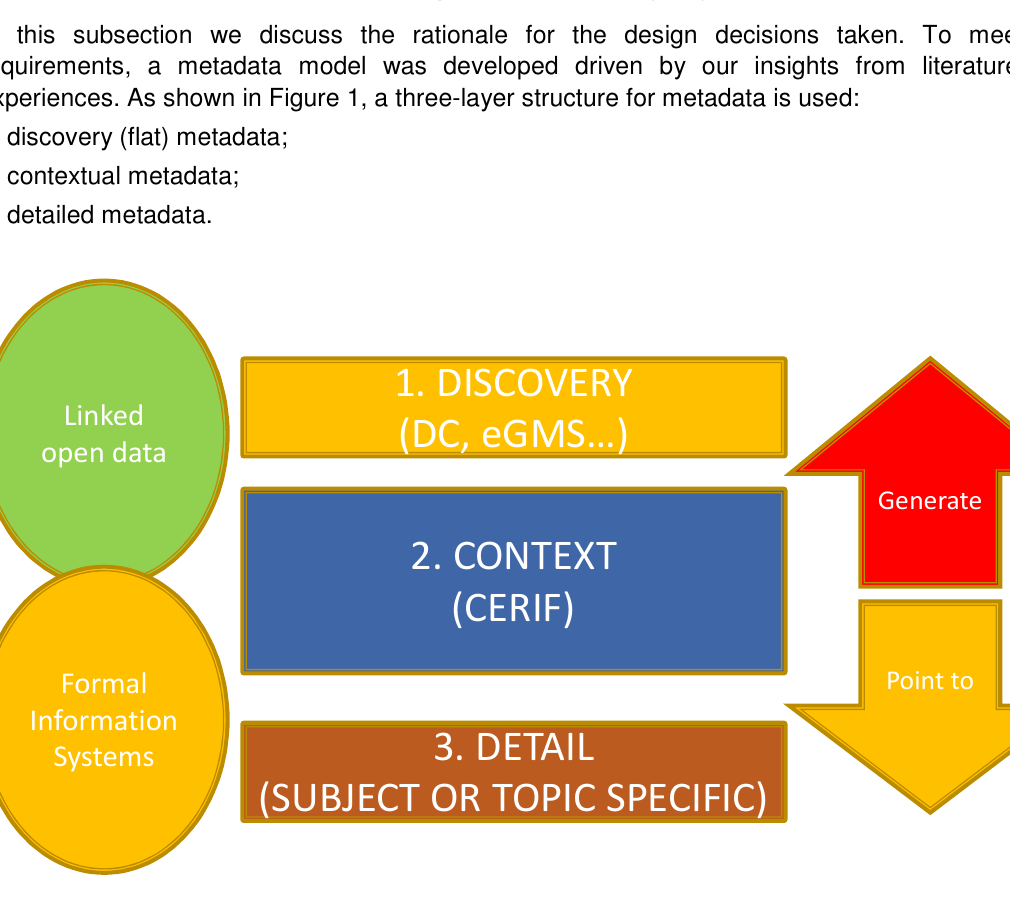
Figure 1: The three-layer metadata